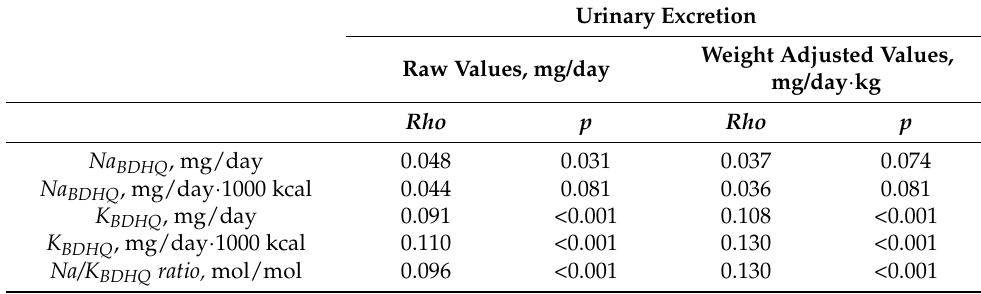
BDHQ ratio: sodium, potassium intake, and dietary sodium-to-potassium molar ratio estimated from the BDHQ; Na ex , K ex , and Na/K ex ratio: sodium intake, potassium intake, and dietary sodium-to-potassium molar ratio estimated from overnight urine. Table 3. Spearman’s correlation coefficients ( Rho ) between BDHQ estimation and corresponding urinary excretion ( n =